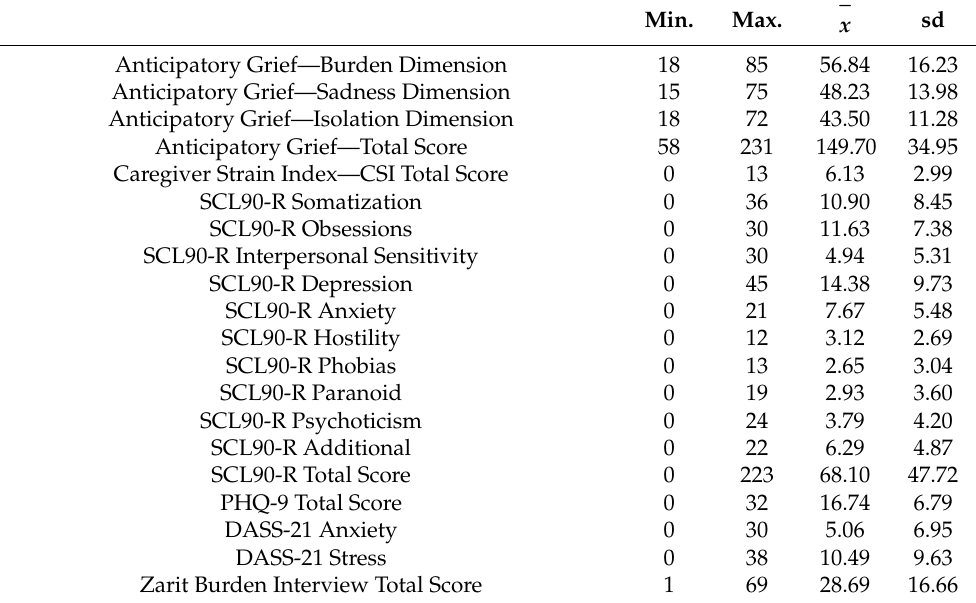
Table 3. Scores on the psychometric tests by the sample of